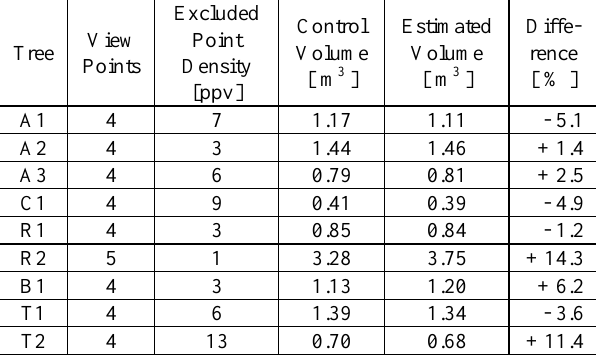
Table 1. Estimated and control volume of scanned